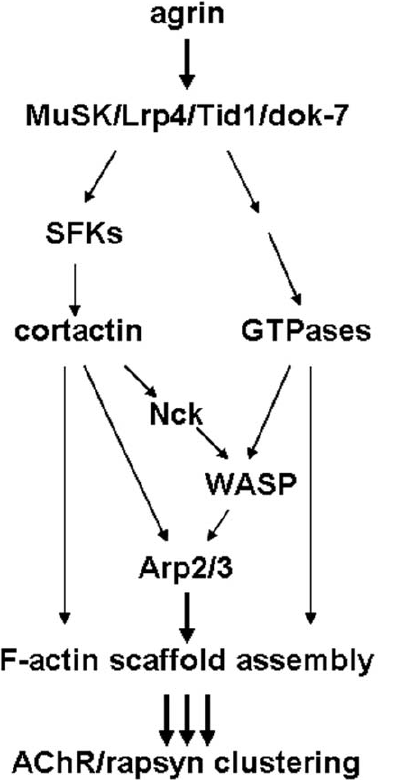
Figure 8. Cortactin signaling in agrin-dependent AChR clus- tering: a model. Activation of MuSK by agrin induces AChR clustering in an actin polymerization-dependent manner. This model depicts a possible way in which cortactin signaling might promote the AChR clustering process. Initiation of intracellular signaling by the activated MuSK complex could enhance cortactin’s tyrosine phosphorylation through src family tyrosine kinases (SFKs) (and possibly other kinases such as abl), and cortactin, in turn, could increase actin polymerization. Alternatively, cortactin might trigger actin polymerization by activating the Arp2/3 complex, either on its own or in concert with WASP-related proteins (N-WASP, WIP, etc.) to which it could be linked by the adapter Nck. In parallel, via other signaling intermediates, MuSK could stimulate Rho-family GTPases and, through them, F-actin assembly. Such enhanced and dynamic actin polymerization at synaptic sites could generate a scaffold which ‘‘traps’’ AChRs through rapsyn.